Question: Condense the content of this figure into a single sentence.
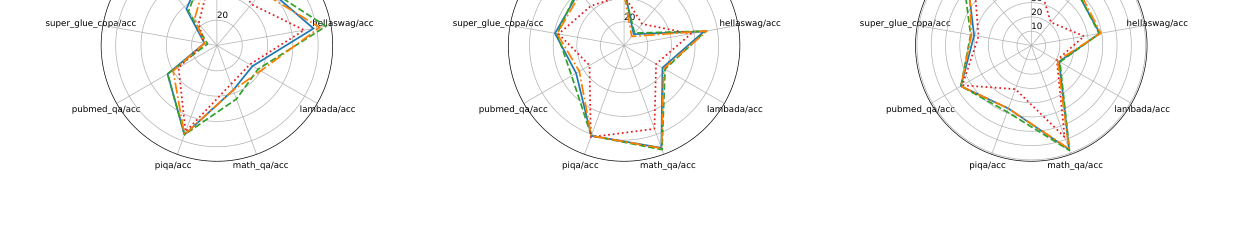
Answer: The average accuracy scores across nine language reasoning tasks. From left to right: unlearning 8 samples, 16 samples, and 32 samples at once, respectively. Results based on the 1.3B checkpoint.